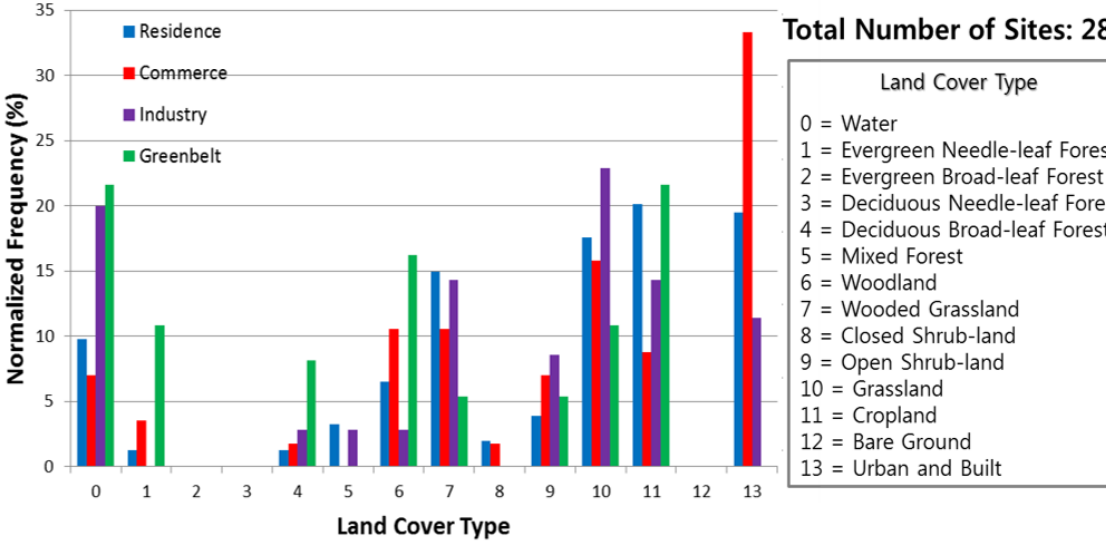
Figure 2. Satellite-derived AVHRR land-cover types with respect to the MEK four land-use types (residence, commerce, industry and greenbelt) of 283 air pollution monitoring stations of the MEK in South Korea. The 13 AVHRR types were given at a 1km × 1km pixel resolution (e.g., De Fries et al., 1998; Hansen et al., 2000). Table 3. Methods and instruments for measuring the surface air pollutants (O 3 , CO, NO 2 , SO 2 , and PM 10 ) at 283 MEK air pollution monitoring stations in South Korea during